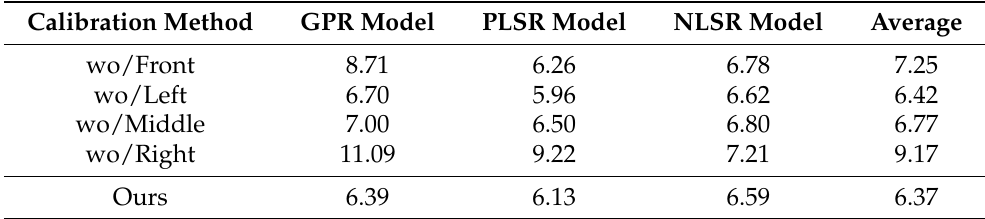
Table 2. Absolute mean error (degree) of gaze estimation performance on different calibrated gaze zones. wo/means without the calibration data from the given gaze zone. Front: GZ14; Left: GZ3; Middle: GZ6; Right: GZ35; wo/Calibration: without any